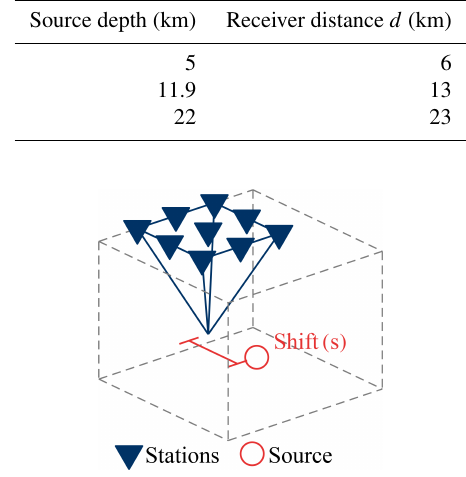
Figure 6. The placement of the nine stations used as receivers for testing the influence of an array which is not centred above the source. The shift ( s ) was discretely